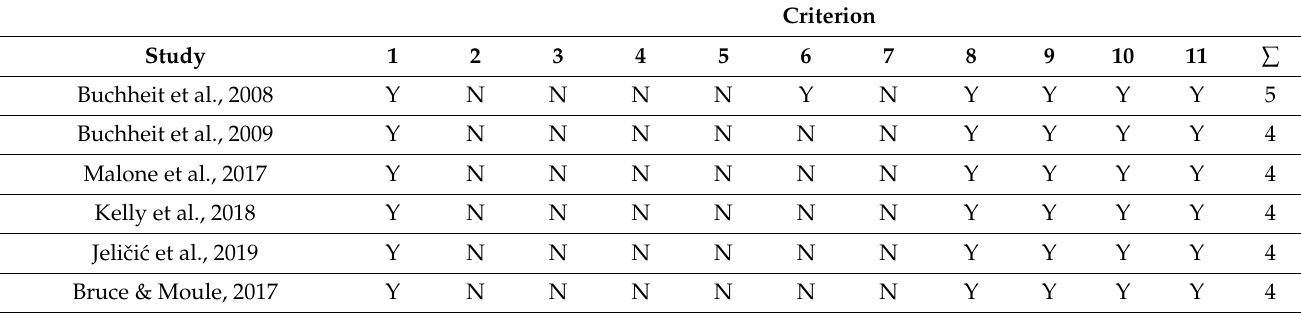
Table 1. PEDro Scale for studies where IFT 30–15 is used to verify validity, reliability and aerobic capacity assessment.